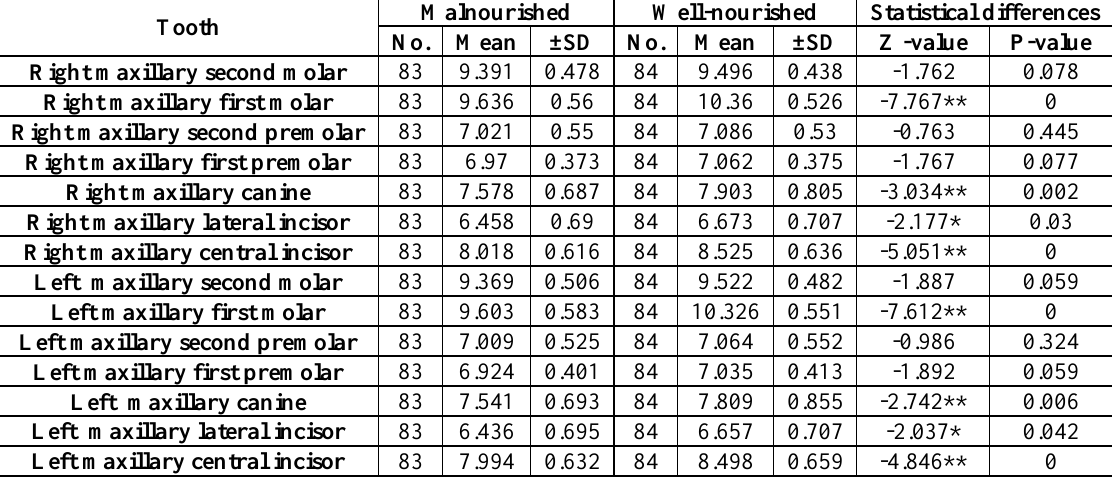
Table 1: Measurement of mesiodistal diameters (mm) of maxillary teeth in malnourished and well-nourished group among adolescent aged 15 years by gender Malnourished Well-nourished Tooth